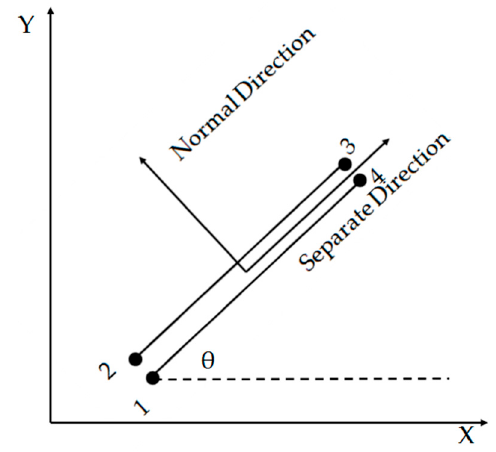
Figure 3. The schematic of the Goodman element in global coordinate system.